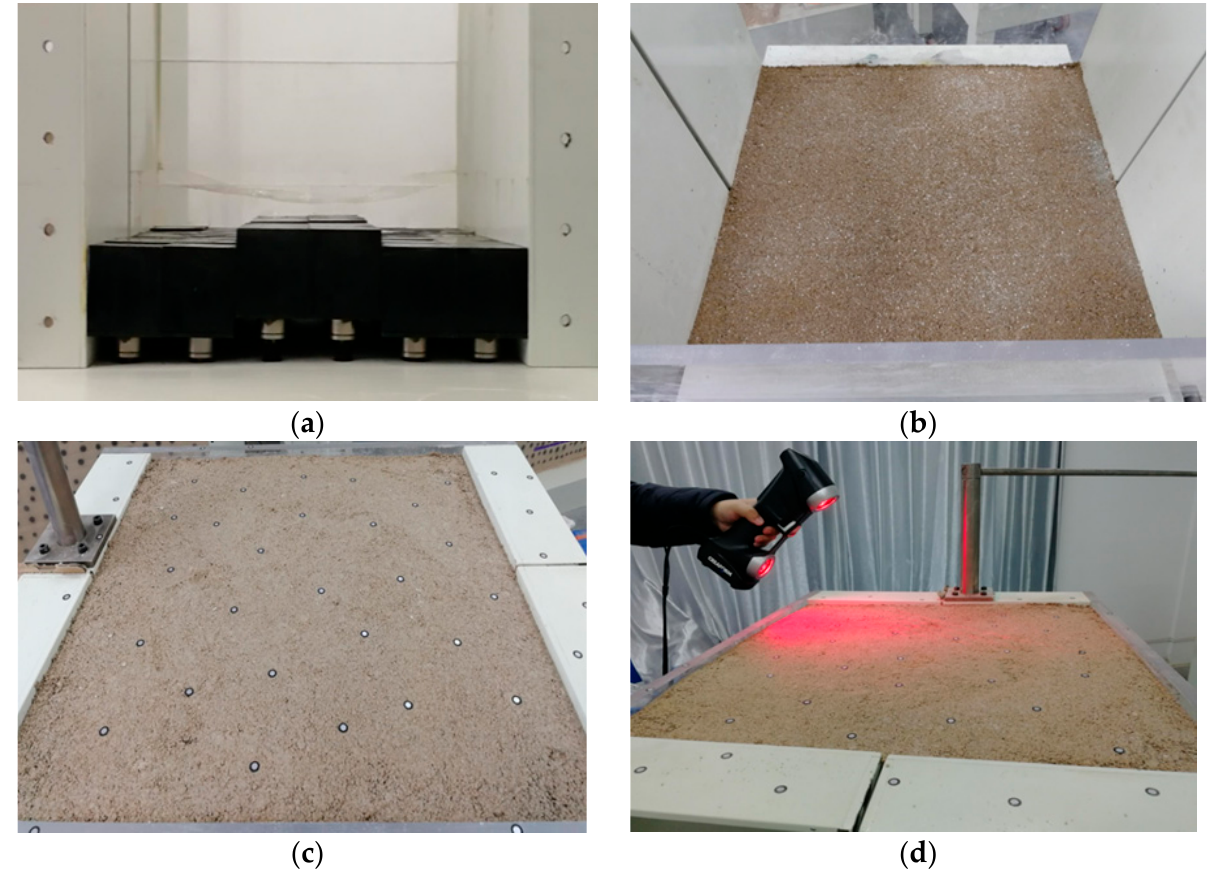
Figure 5. Operating steps of the test process: ( a ) adjusted mining blocks; ( b ) layered laying model; ( c ) placement location punctuation; ( d ) three-dimensional scanning monitoring.